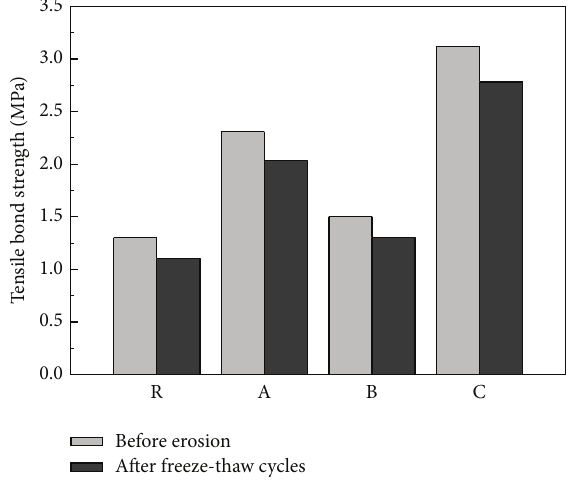
Figure 5: Tensile bond strength of repair mortars before and after freeze-thaw cycles.